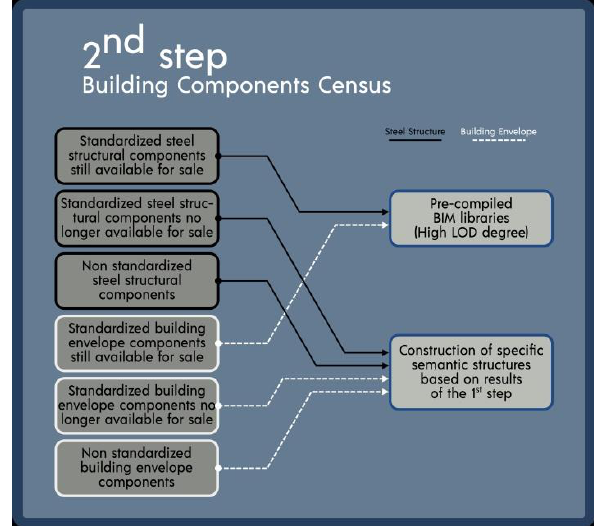
Figure 5: the second step framework, consisting in a building components